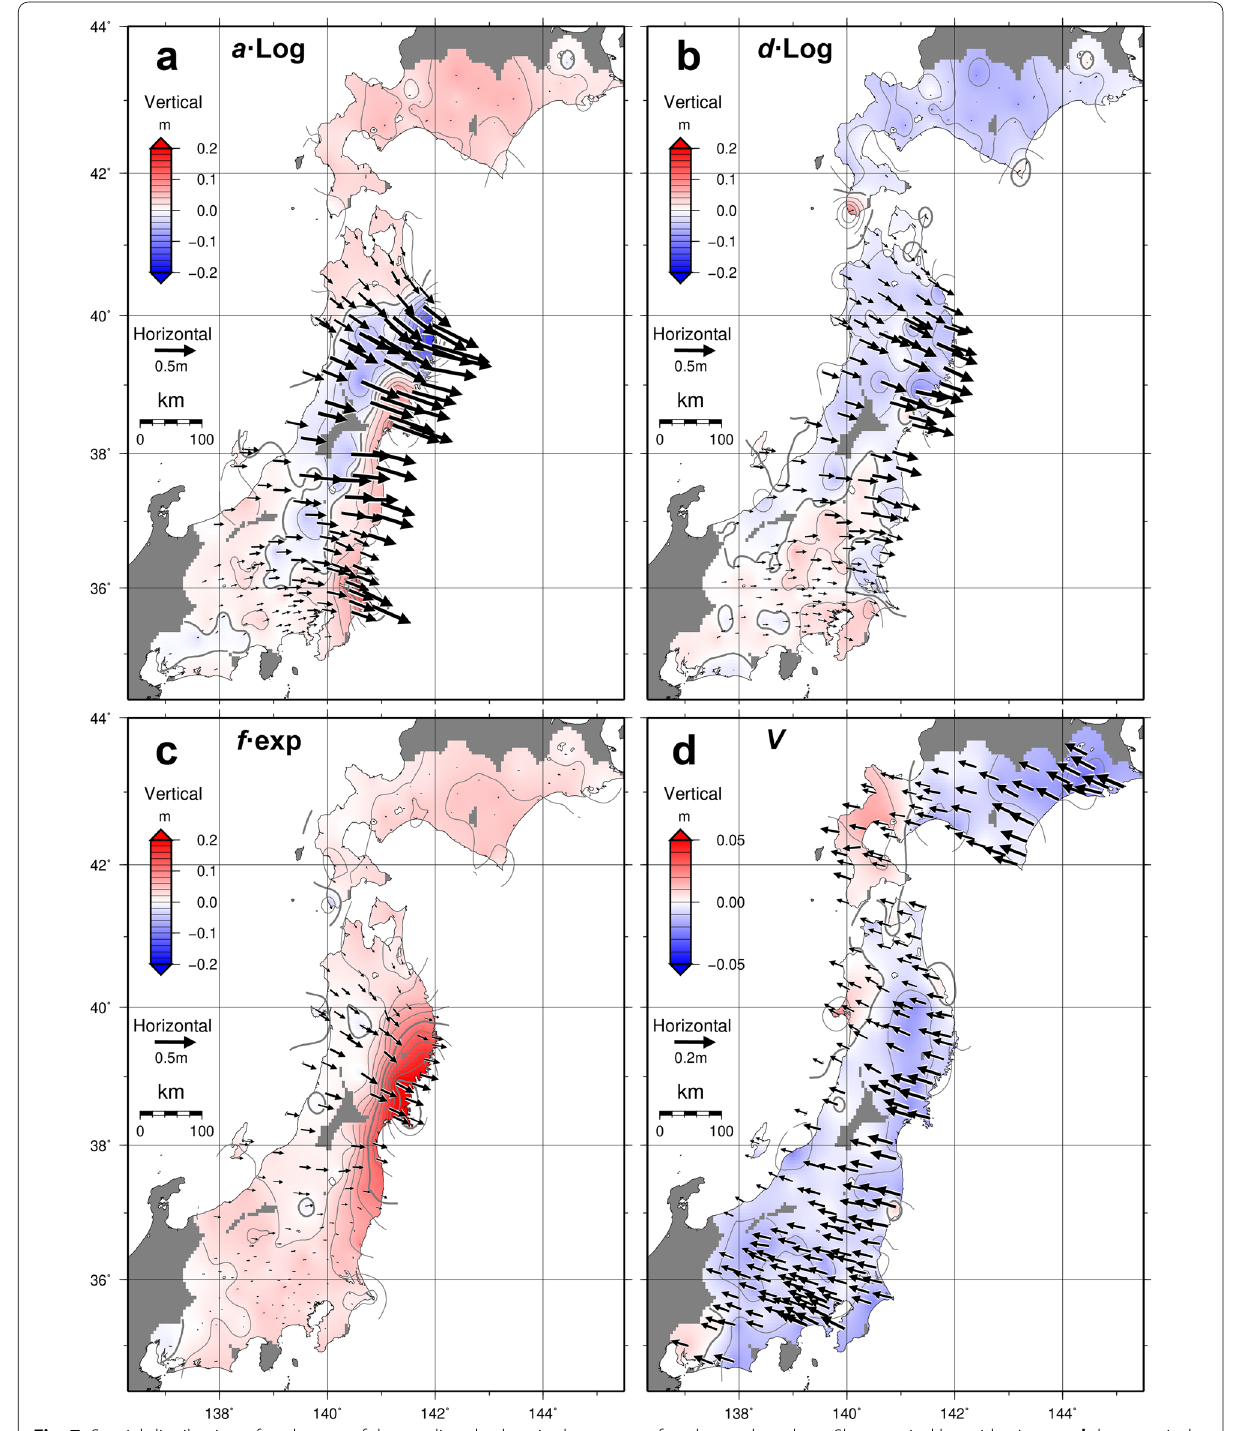
Fig. 7 Spatial distribution of each term of the predicted values in three years after the earthquake. a Short-period logarithmic term, b long-period logarithmic term, c exponential term, and d steady velocity term Vt in Eq. (4). The values for each term represent the distribution for three years after the earthquake (March 11, 2014), with the values immediately after the earthquake set to